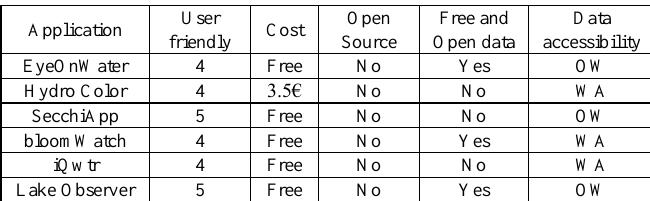
Table 1: Summary of the applications review (values for category ‘User friendly’ range from 1-bad to 5-excellent, acronyms for data accessibility OW-data available on